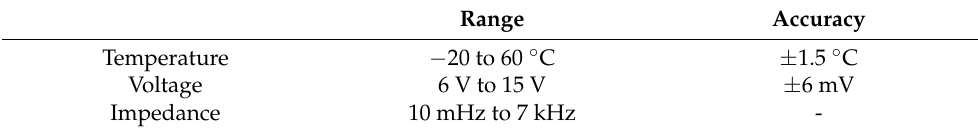
Table 1. Accuracy of the VTZ sensor.